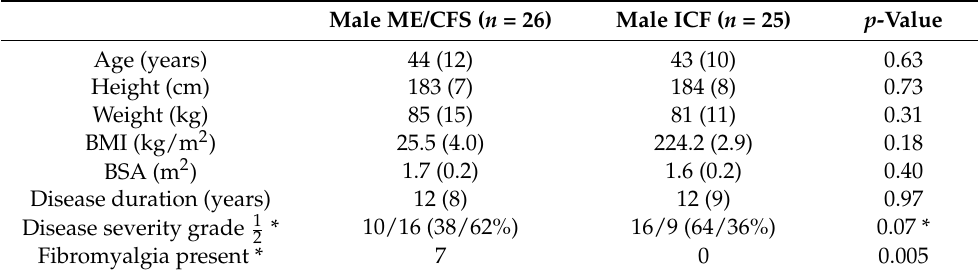
Table 1. Baseline